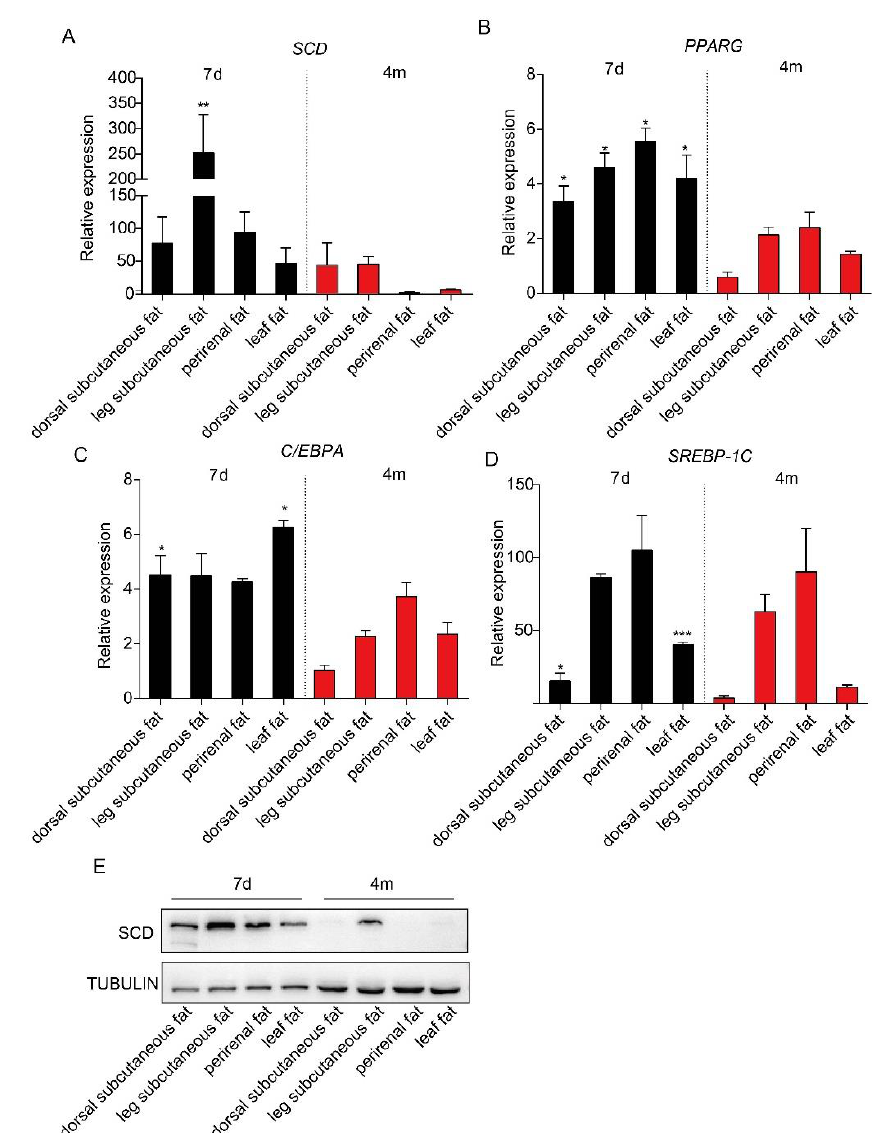
Figure 1. The expression level of stearoyl-CoA desaturase (SCD) and three transcriptional factors in various adipose depots from piglets and adult pigs. Subcutaneous adipose tissue from the dorsal and leg, perirenal adipose tissue, and leaf adipose tissue were collected from seven-day-old and four-month-old Bama pigs ( n = 3/group). Real-time PCR results showed the expression levels of SCD ( A ), PPARG ( B ), C / EBPA ( C ) and SREBP-1C ( D ) in these adipose tissues. * p < 0.05, ** p < 0.01 and *** p < 0.001 were considered significant. ( E ) Western blot analysis results of SCD expression in the adipose tissues from seven-day-old piglets and four-month-old adult pigs.